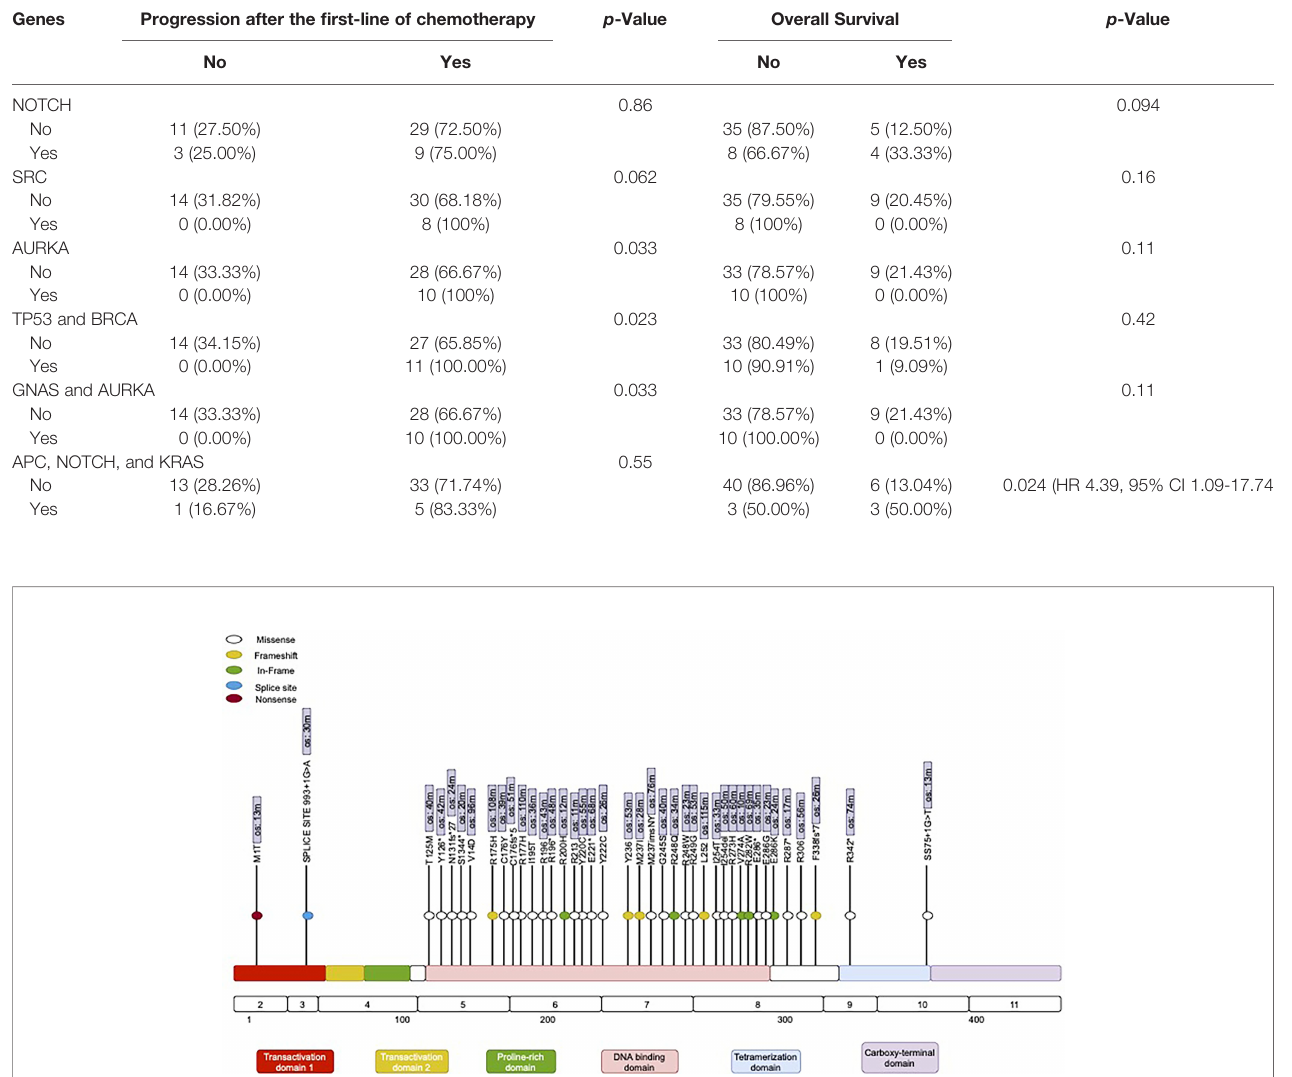
TABLE 4 | Associations of genes and combinations of genes with disease progression and overall survival. Genes Progression after the fi rst-line of chemotherapy p